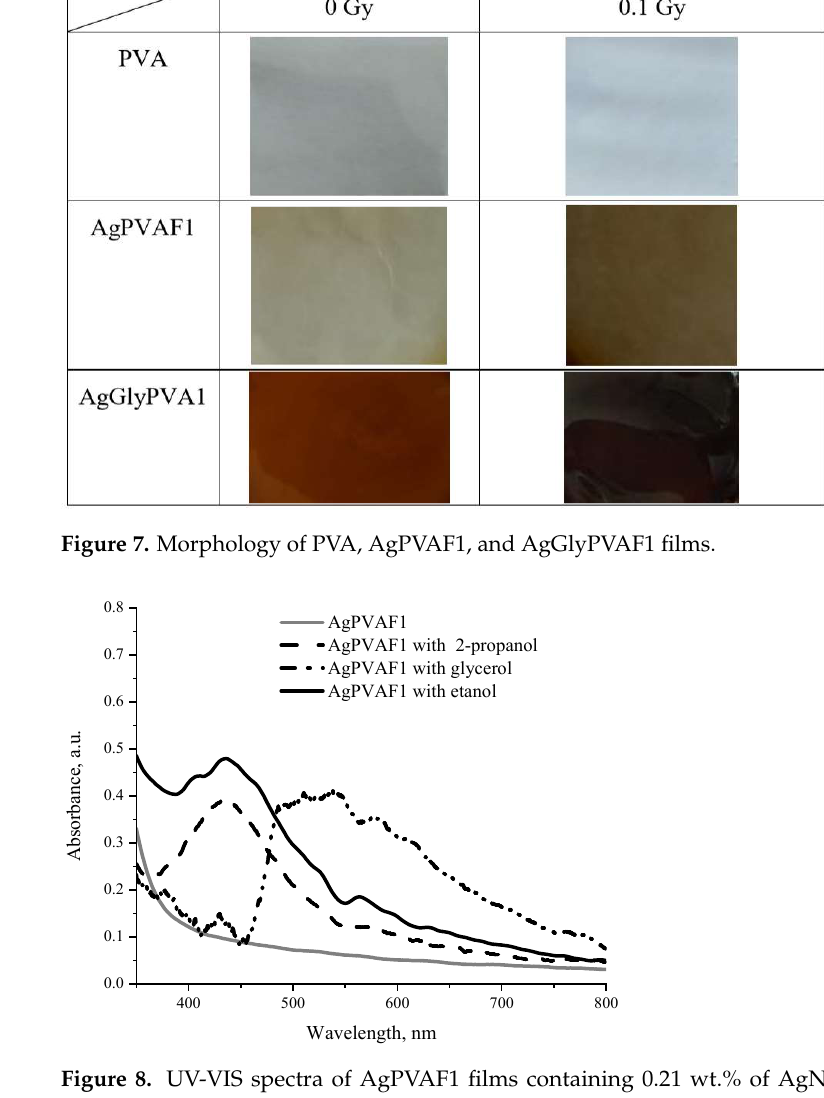
Figure 8. UV-VIS spectra of AgPVAF1 films containing 0.21 wt.% of AgNO 3 and glycerol (Ag- GlyPVAF1), ethanol (AgEtaPVAF1), or isopropanol (AgIzoPVAF1) additives and irradiated with 4 Gy doses.